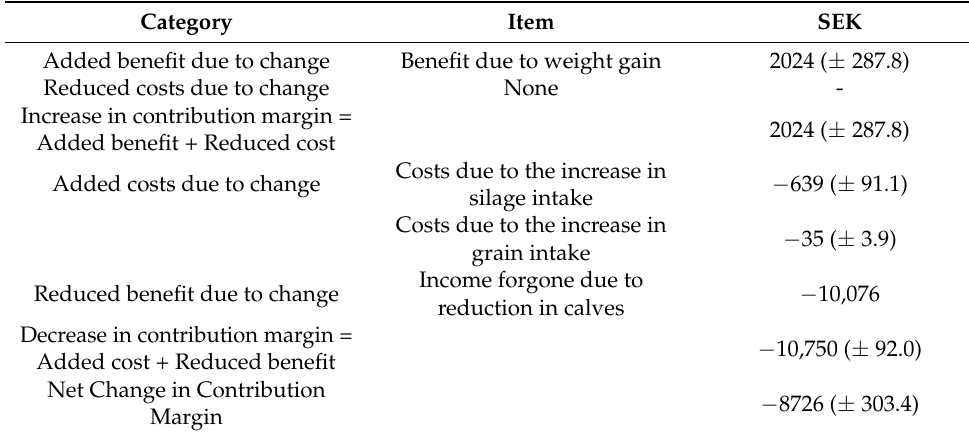
Table 2. Effects a of an increase in space allowance (from 2.2 to 2.7 m 2 /calf)—Scenario